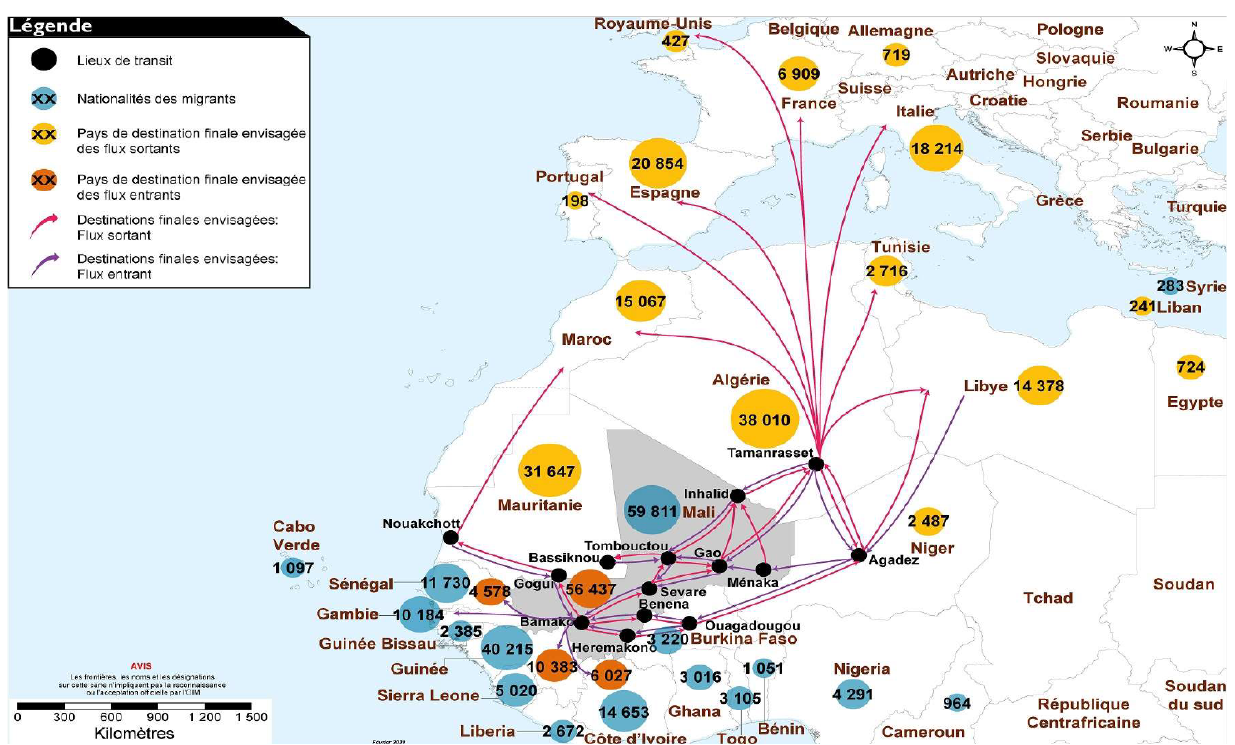
Figure 1. Map of migration routes. Notes: The designations employed and the presentation of material on the map repro- duced in this article do not imply the expression of any opinion whatsoever on the part of the IOM; all data are based on estimates. Source: IOM